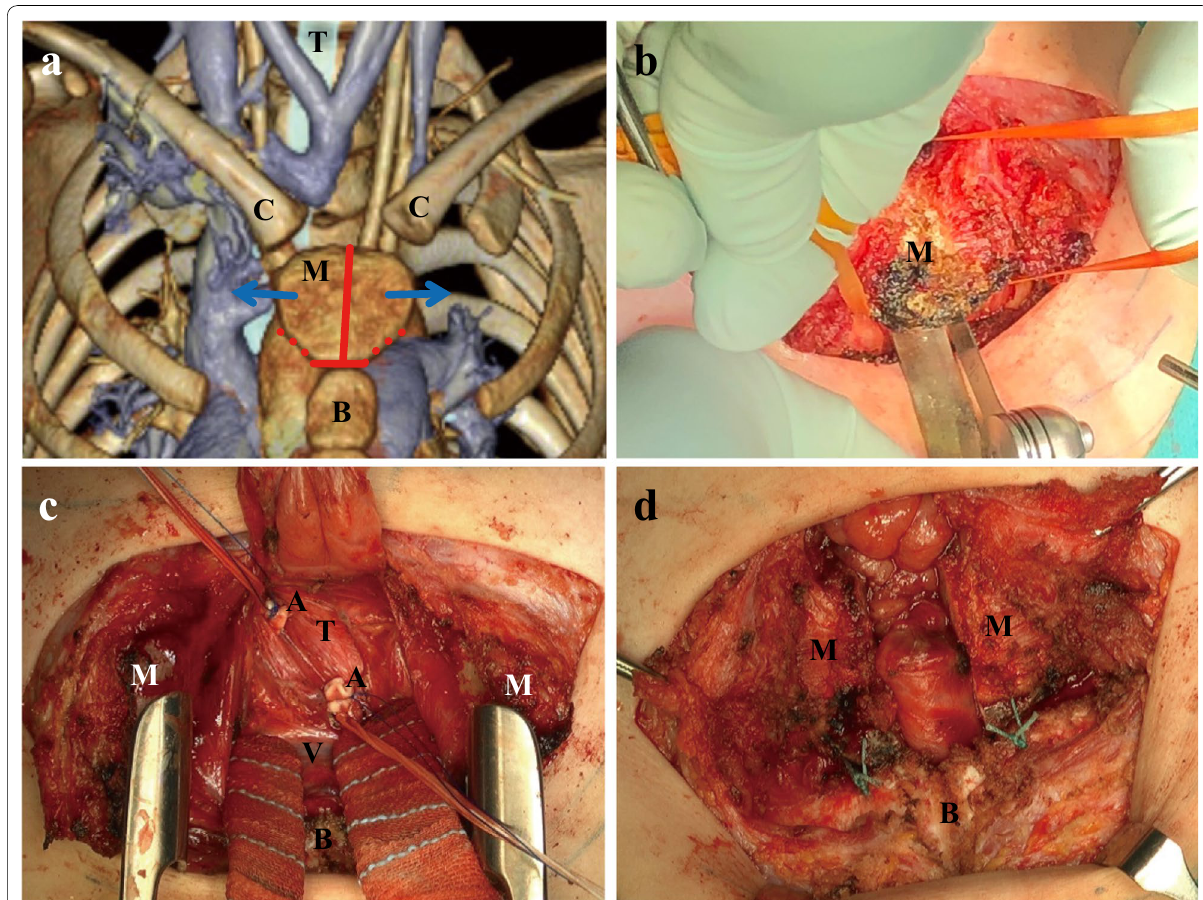
Fig. 1 Imaging and intraoperative photographs in Patient 1. a Concept of the inverse T-shaped sternotomy on three-dimensional computed tomography (CT) imaging. Red and dotted lines indicate the lines of the sternotomy and the line of detachment between the second costal cartilage and the manubrium, respectively. b Manubriotomy from the caudal side using an oscillator. c Brachiocephalic artery transection. Note that the trachea is compressed between the transected artery. d Fixation of the halves of the divided manubrium to the bilateral second costal cartilage. A brachiocephalic artery; B sternal body; C sternal end of the clavicle; M manubrium sterni; T trachea; V brachiocephalic